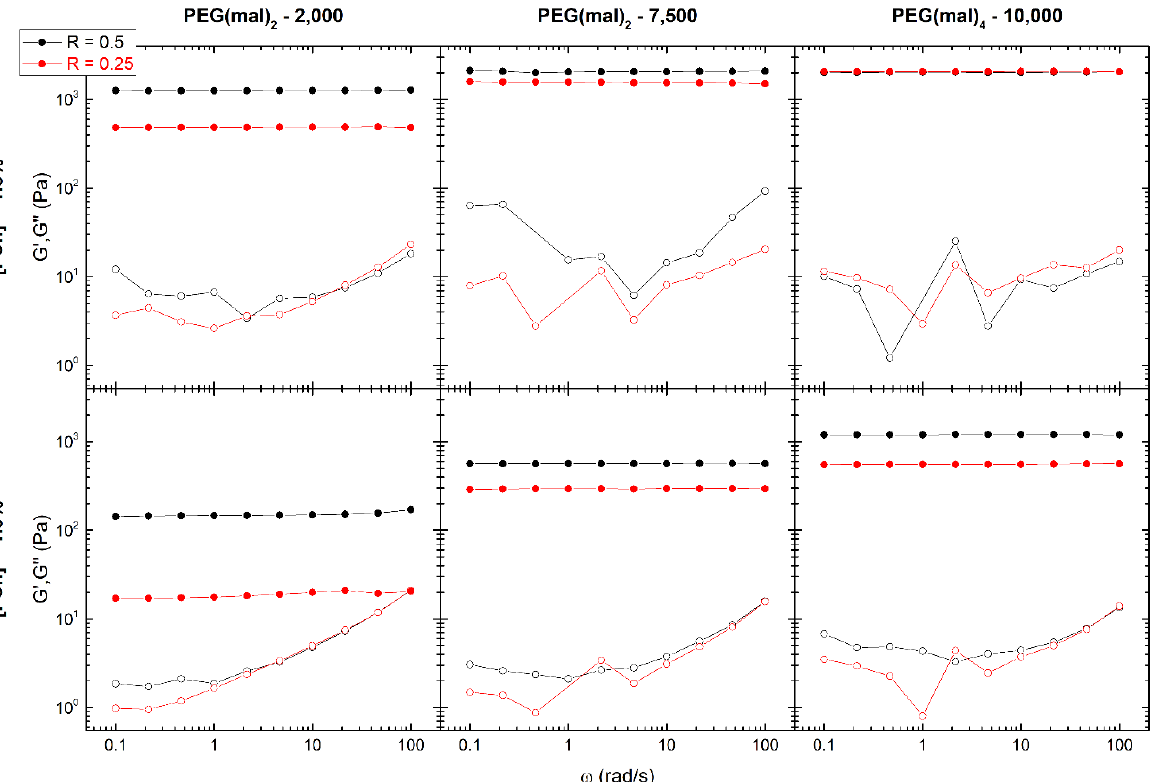
Figure 5. Mechanical spectra of N -furfuryl chitosan hydrogels based on the Diels – Alder click reaction varying the degree of polymerization and functionality of the PEG-maleimide compound, as indicated in the figure. Frequency sweeps were performed at 25 °C and γ = 2.5 %, after gelation at 70 °C. N -furfuryl chitosan (21% degree of substitution) dissolved in 2% acetic acid. Polymer concentration: 1.0 and 1.8 wt.%, and R = 0.25 (red) and 0.5 (black), as indicated in the figure. G ’, closed symbols, and G ’’, open symbols.